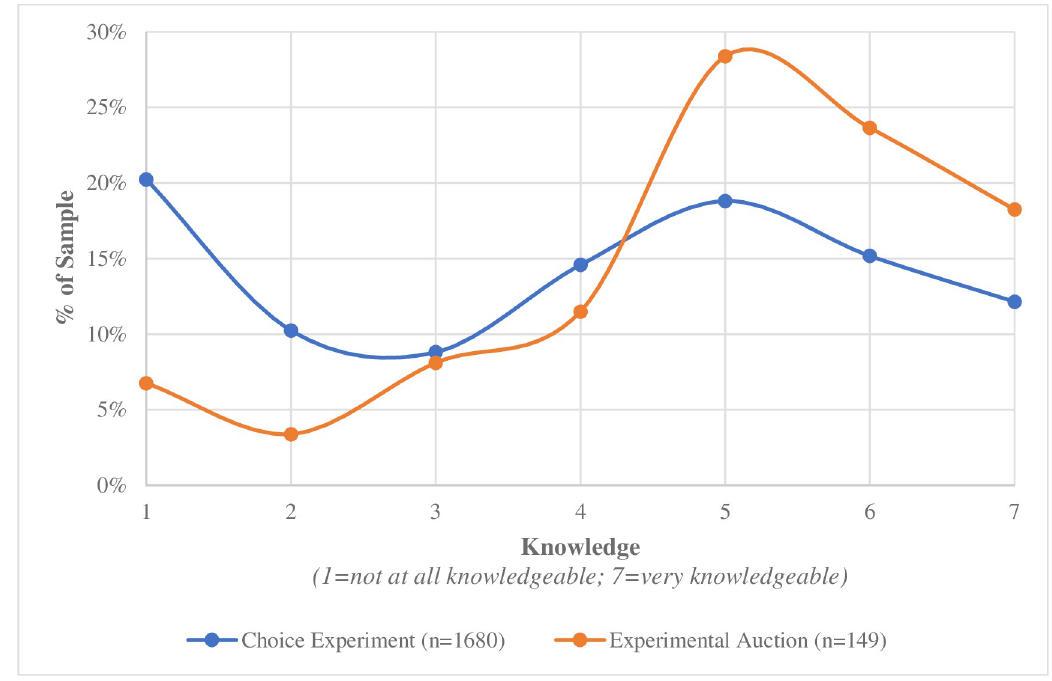
Fig 2. Percent of sample indicating self-reported subjective knowledge of non-GMO product certification, by study.